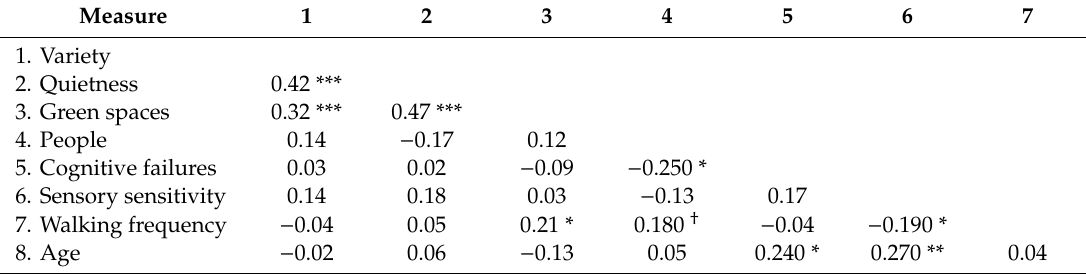
Table 1. Nonparametric